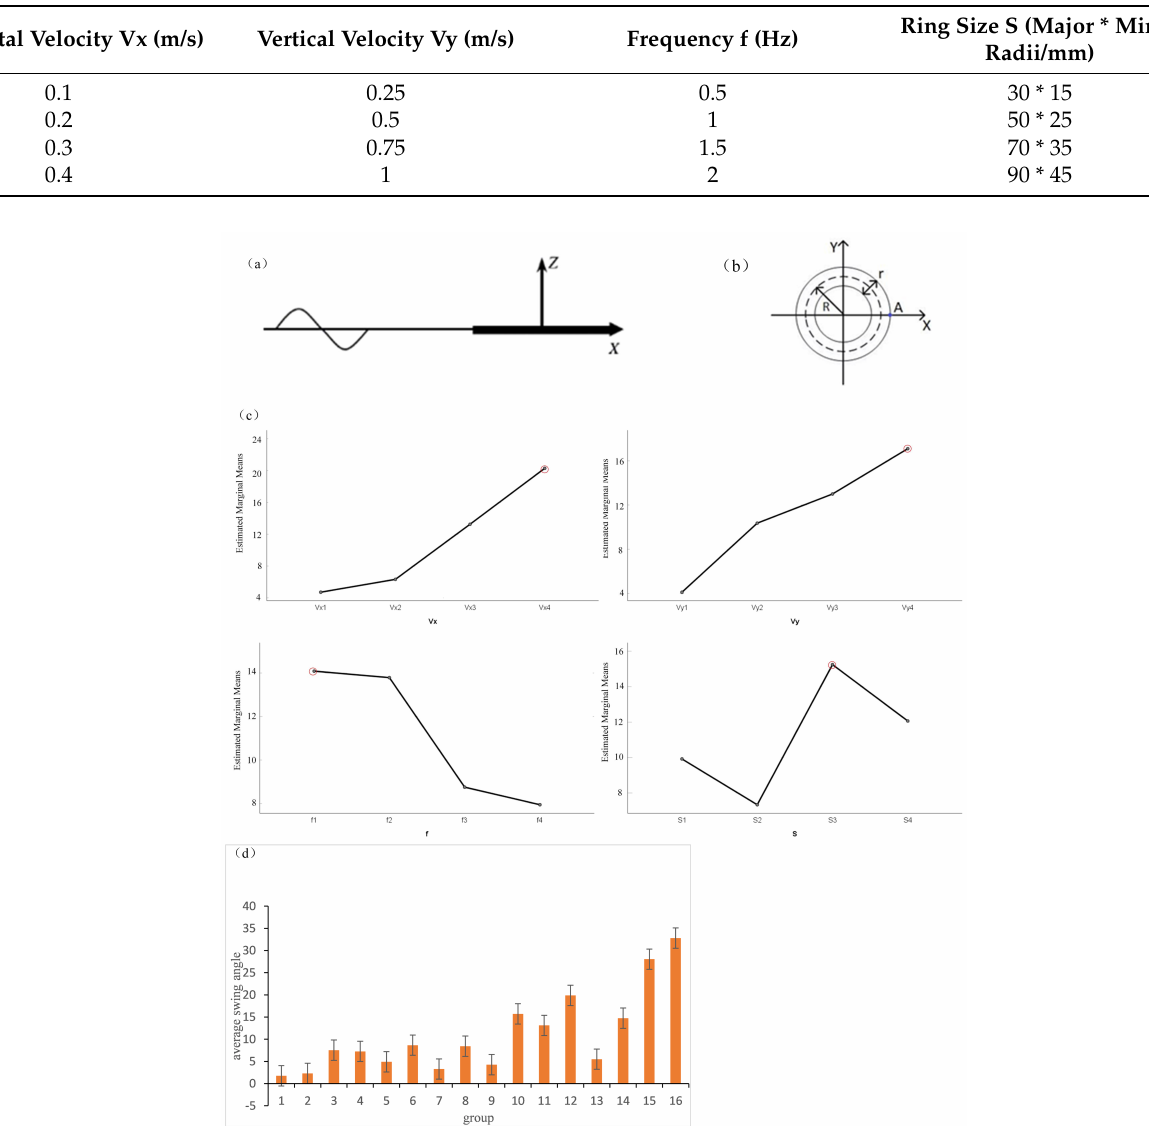
Table 1. The parameter values of the four independent variables.